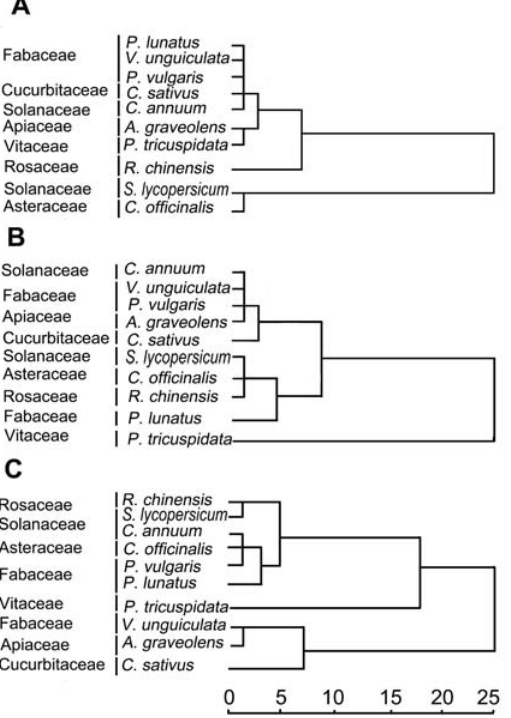
Figure 1. Hierarchical cluster analysis on the homogeneity using between-group-linkage method and square Euclidean distances based on the characters of total amounts and numbers of volatile compounds from: 1A, healthy plants; 1B, mechanically damaged plants; and 1C, leafminer-damaged host or JA-treated non-host plants of pea leafminer. The X axis is the relative distance between plants of seven plant families.